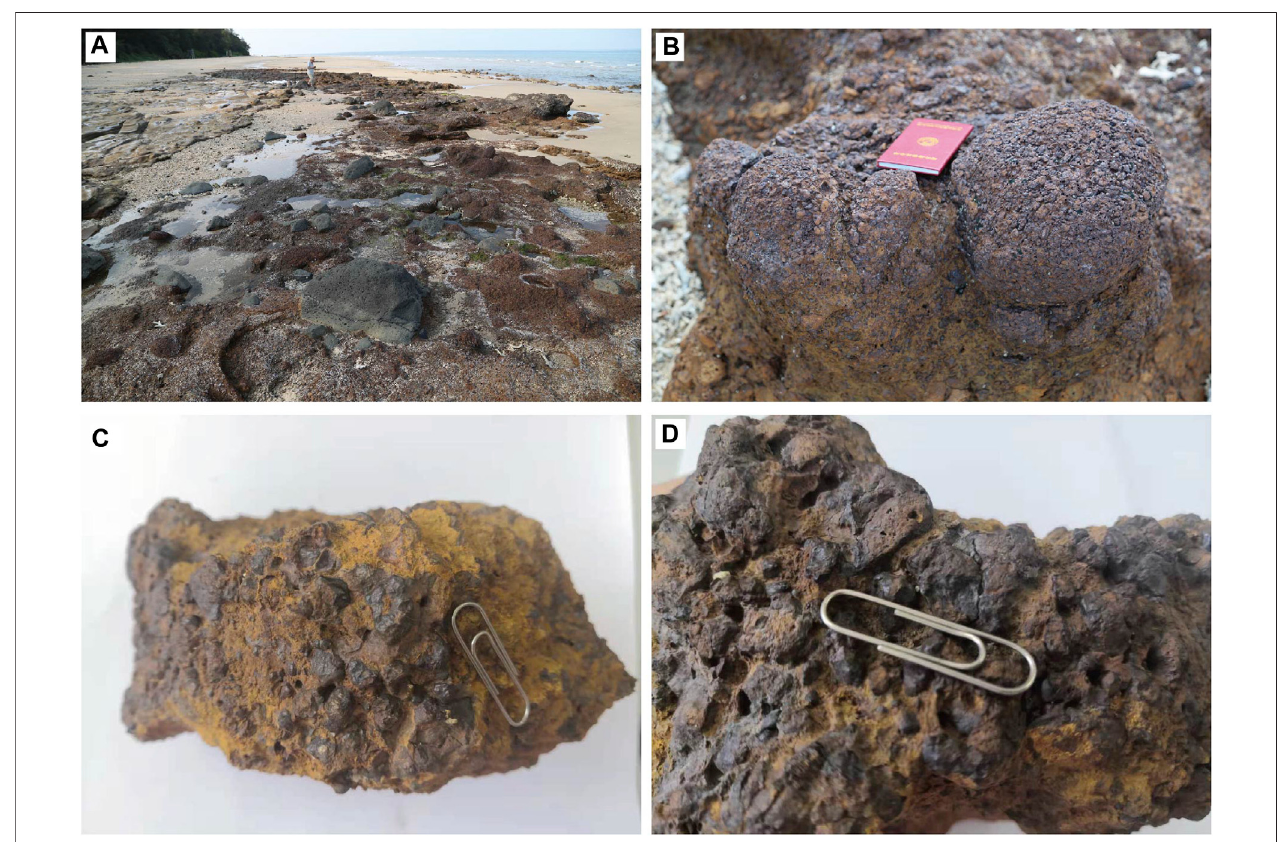
FIGURE 3 | Field photographs of Hengling volcano products. (A) Banded volcanic breccias and volcanic bombs inside the breccias. (B) Spheroidal weathered indurated volcanic breccias. (C) Indurated volcanic breccias with weathered matrix. (D) Volcanic breccias with diameter of 0.5 – 2 cm.